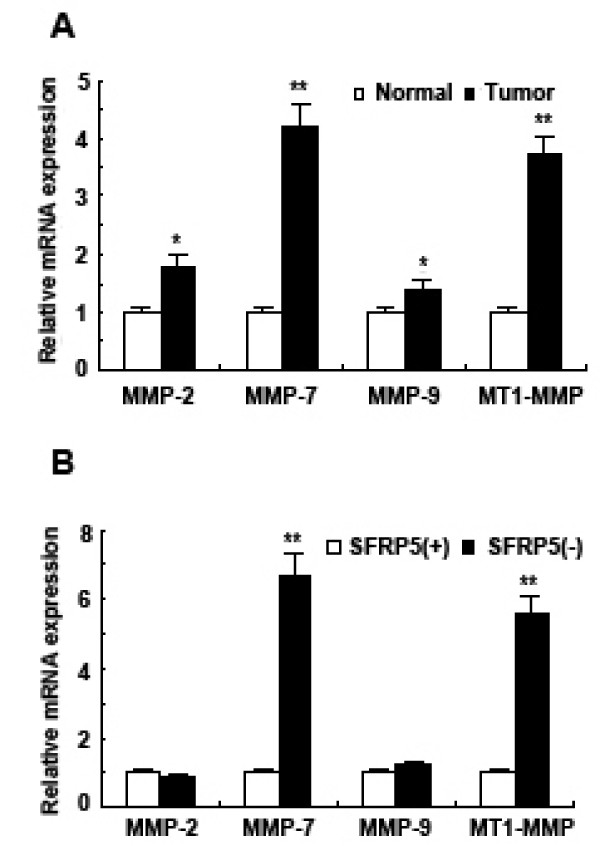
The mRNA expression of MMP-2, MMP-7, MMP-9 and MT1-MMP in primary gastric cancer specimens by Real-time PCR. (A) Gastric cancer specimen (T) expressed higher levels of MMP-2, MMP-7, MMP-9 and MT1-MMP compared to matched normal tissue specimens (N). Data are expressed as mean ± SD, n = 32, *P < 0.01, **P < 0.001, vs Normal. (B) SFRP5 expression-negative gastric cancer specimens (SFRP5-) expressed higher levels of MMP-7 and MT1-MMP compared to SFRP5 expression-positive (SFRP5+) gastric cancer specimens. Data are expressed as mean ± SD, n = 24 and 8, respectively, **P < 0.001, vs SFRP5(+).